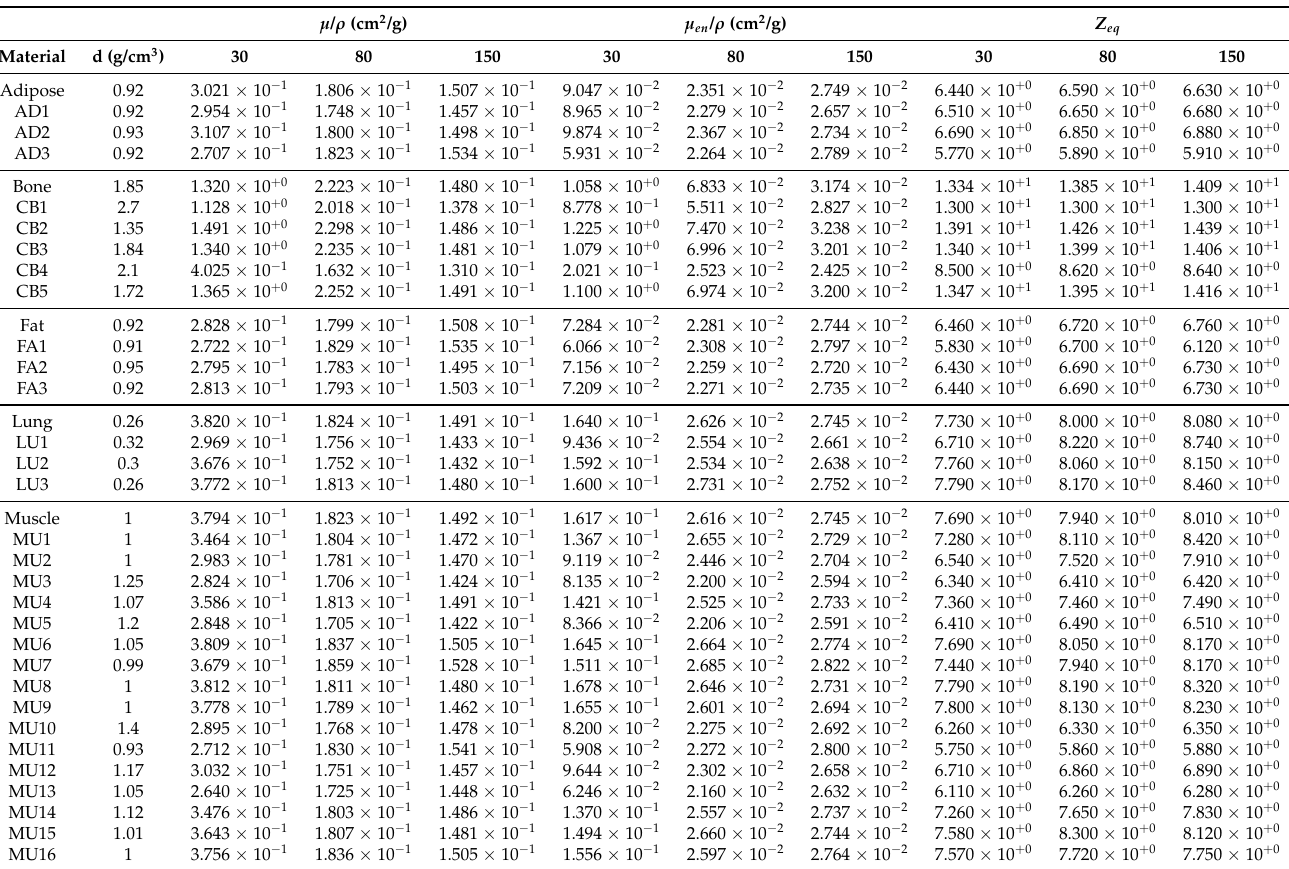
Table 2. Tissue and equivalent material candidate properties: atomic density (g/cm 3 ), mass attenua- tion coefficient, mass energy-absorption coefficient (cm 2 /g), and equivalent atomic number ( Z eq ) at different photon energy of 30, 80, and 150